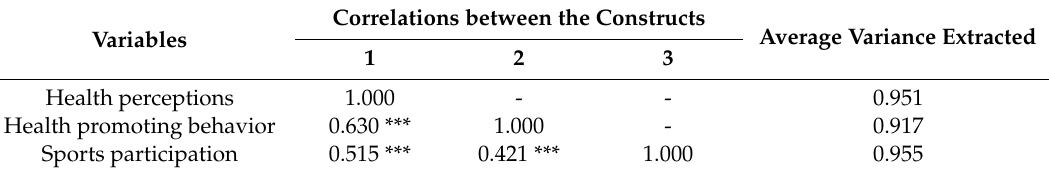
Table 5. Discriminant validity